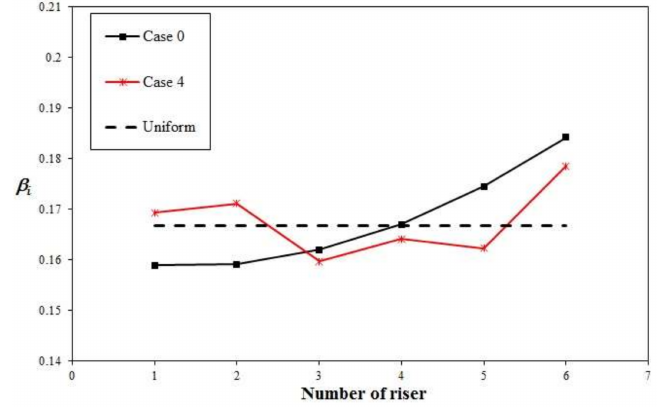
Figure 10. Average velocity in riser tubes at different volumetric flow rates. Flow distribution comparison between Case 0 and Case 4 at 2 L/min.